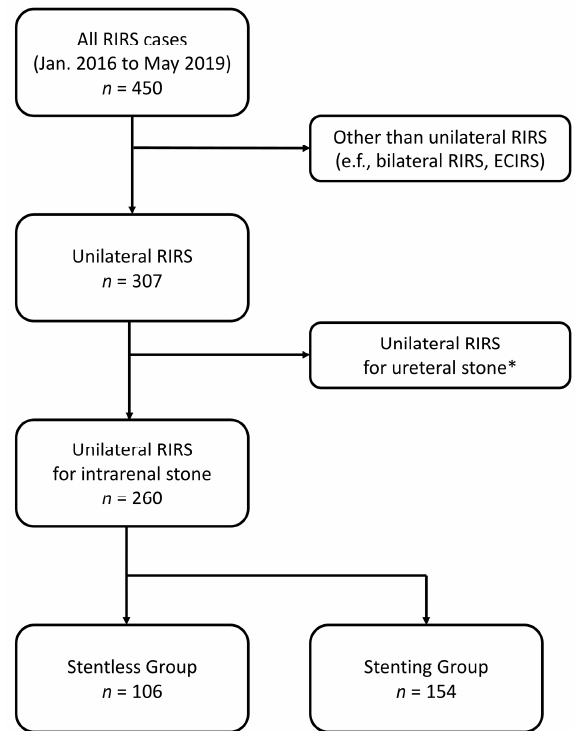
Figure 1. Flowchart of our retrospective study design. RIRS = retrograde intrarenal surgery, ECIRS = endoscopic combined intrarenal surgery. * Confirmed by surgical record and routinely performed preoperative CT imaging.